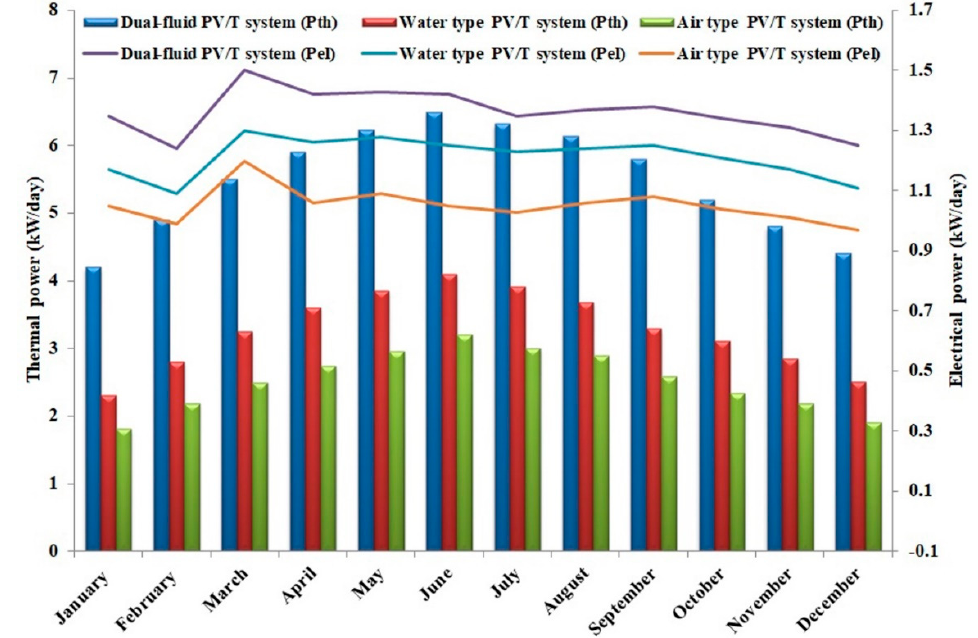
Figure 9. Monthly variations of thermal and electrical powers of the PV/T systems across the year.